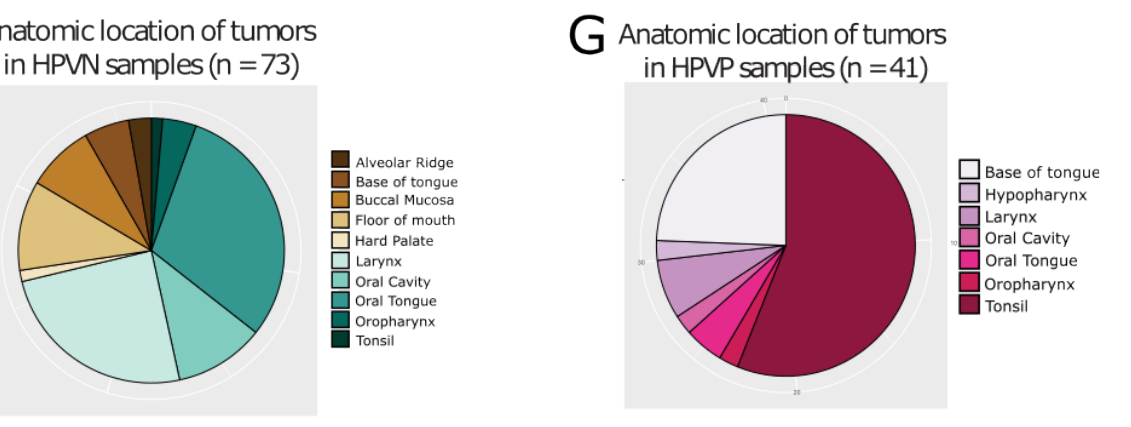
Figure 1 . Clinical data of the TCGA HNSCC HPV- positive and negative patients. Patients were filtered according to the HPV status using the information regarding p16 expression and in situ hybridization information (only patients with information present were included in the study; n = 114, HPVP = 41, HPVN = 73). ( A ) Distribution of age at cancer diagnosis between two groups of patients, HPVP and HPVP; ( B ) distribution of patients in different age groups, and sidewise comparison of age groups and HPV status; ( C ) representation of male and female patients, HPVP and HPVN; ( D ) representation of different races, independent of sex or HPV status; ( E ) distribution of different anatomical sites where cancer originated; ( F , G ) a closer look at the specific location of HPVN patients ( F ) and HPVP ( G ).